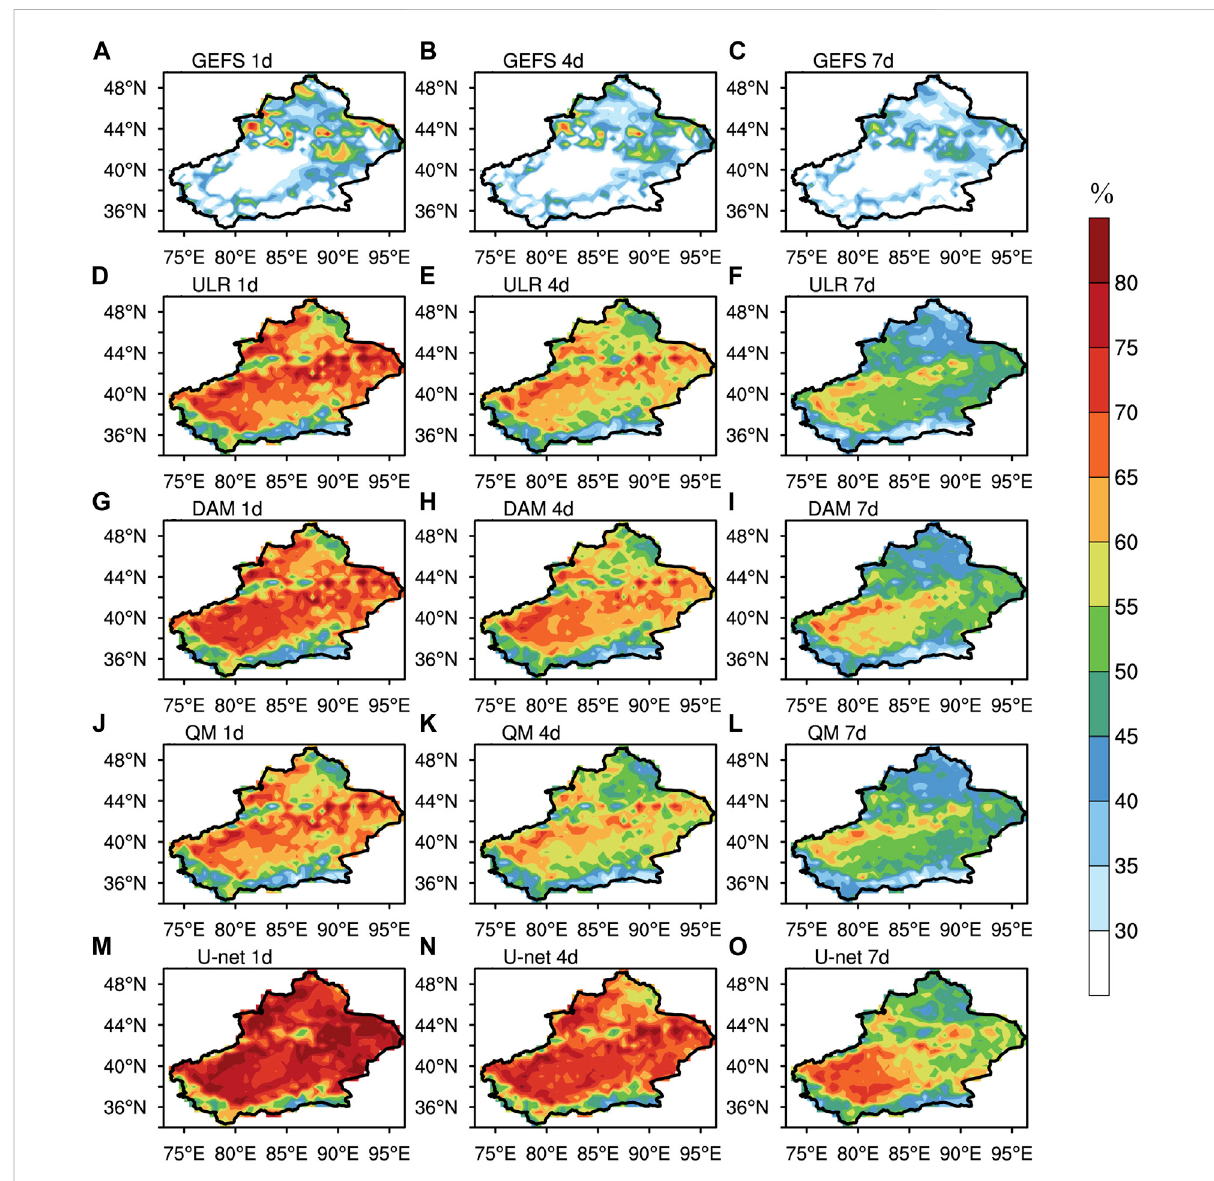
FIGURE 6 SpatialdistributionsofHR2s(%)forsurfaceairtemperatureforecastswithleadtimesof1,4,and7daysderivedfromGEFS (A – C) ,ULR (D – F)